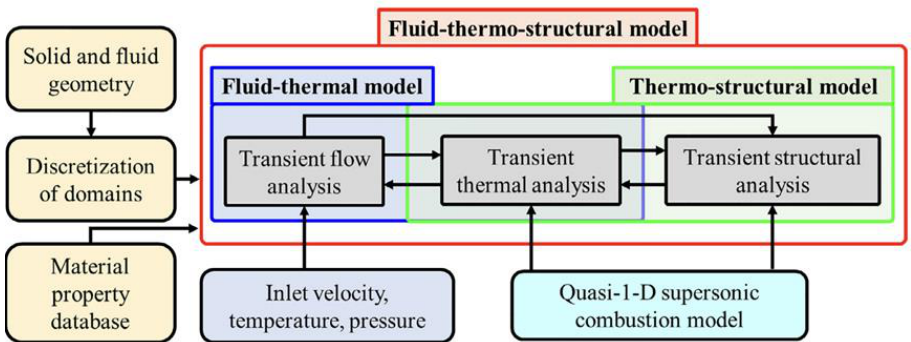
Figure 3. Numerical framework of the semi-coupled fluid – thermo – structural analysis methodology [27].